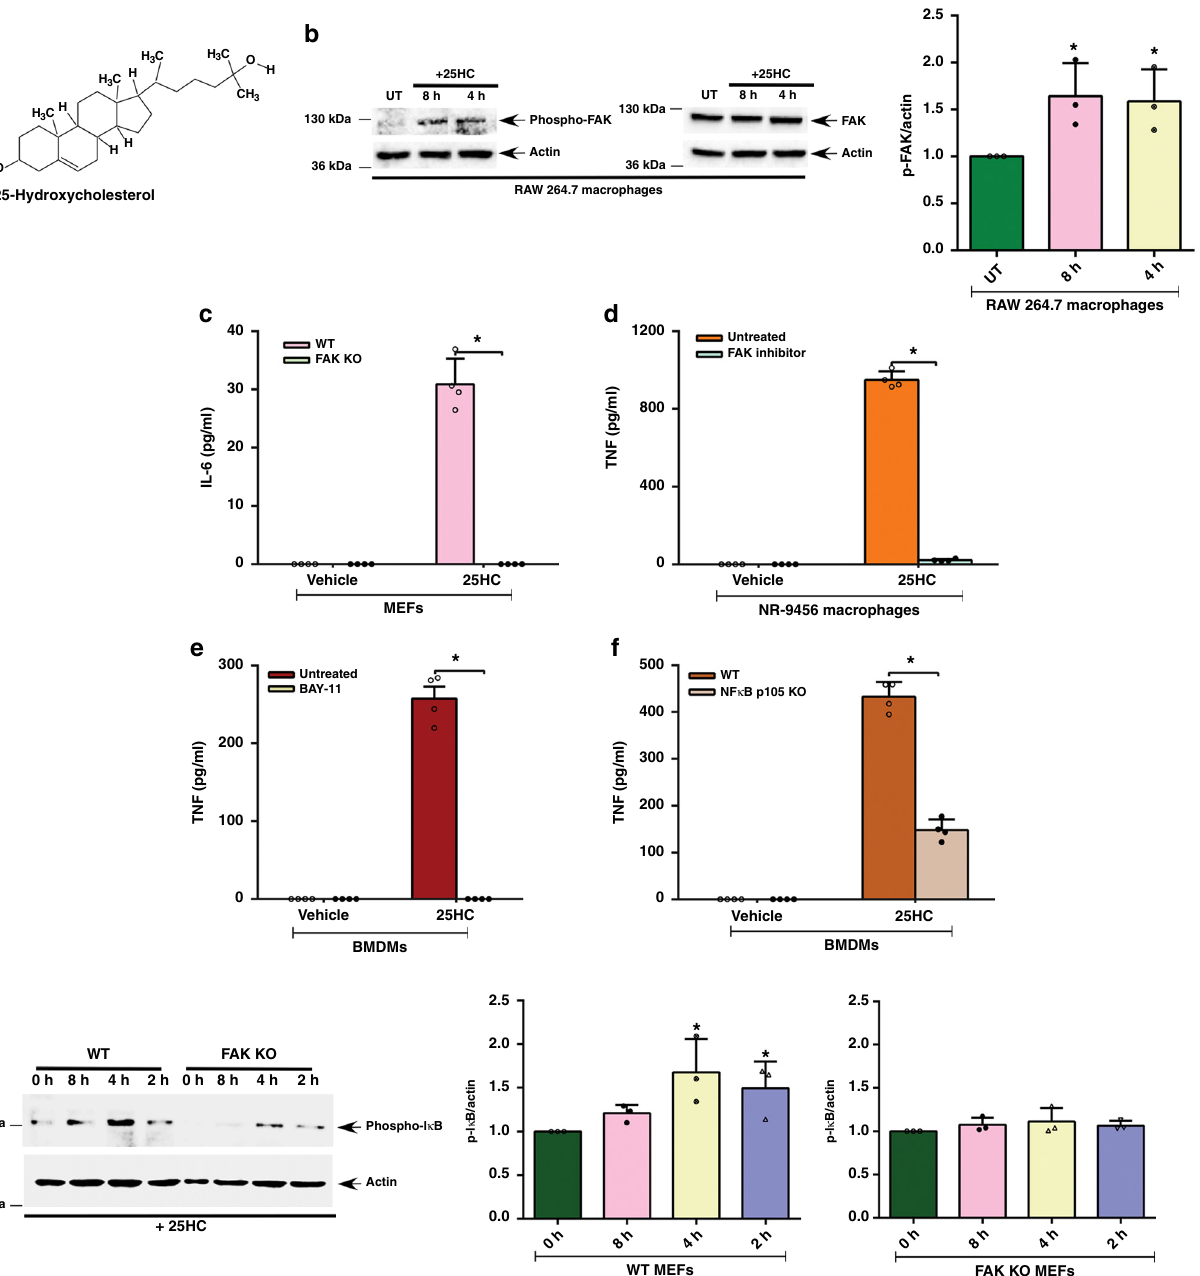
Fig. 1 FAK-NF κ B pathway is required for 25HC-dependent proin fl ammatory response. a Structure of 25-hydroxycholesterol (25HC). b – g Cells were treated with 50 µ M 25HC for 8 h. FAK and NF κ B activation and proin fl ammatory response in treated cells were evaluated. b Western blot and densitometric analyses of FAK activation (phospho-FAK, Tyr925) status in 25HC-treated RAW 264.7 macrophages. c IL-6 secretion from wild-type (WT) and FAK knockout (KO) MEFs (mouse embryo fi broblasts) treated with 25HC. d TNF secretion from NR-9456 macrophages treated with 25HC in the absence or presence of FAK inhibitor (5 µ M). e TNF secretion from BMDMs treated with 25HC in the absence or presence of NF κ B inhibitor Bay 11-7082 (BAY-11) (10 µ M). f TNF secretion from WT and NF κ B p105 KO BMDMs treated with 25HC. g Western blot and densitometric analyses of phospho-I κ B status in 25HC-treated WT and FAK KO MEFs. The ELISA values (mean ± standard deviation) are representative from two or three independent experiments ( n = 4). * p ≤ 0.05 using a Student ’ s t- test. The densitometric quanti fi cation values for phospho-FAK (p-FAK) and phospho-I κ B (p-I κ B) immunoblots represent the ratio of phospho-FAK:actin and phospho-I κ B:actin and the fold-induction was calculated after normalizing with the control untreated (UT) or control 0 h group. The densitometric values represent the mean ± standard deviation from three independent studies. * p ≤ 0.05 using a Student ’ s t- test (Supplementary Fig. 2c) and the complex was subjected to triggered a proin fl ammatory response in macrophages (Supple- western blotting with either α 5 or α v integrin antibodies. Our mentary Fig. 2d). Protein G-agarose beads were conjugated with studies revealed direct association of 25HC with both α 5 β 1 and either control IgG or antibody speci fi c for α 5 and α v integrin α v β 3 integrins (Fig. 2c, d). Finally, we corroborated these fi ndings heterodimers, which were subsequently incubated with puri fi ed α 5 β 1 or α v β 3 integrin, respectively. Control beads and integrin using tritiated-25HC ( 3 H-25HC). 3 H-25HC was active as it NATURE COMMUNICATIONS| (2019) 10:1482